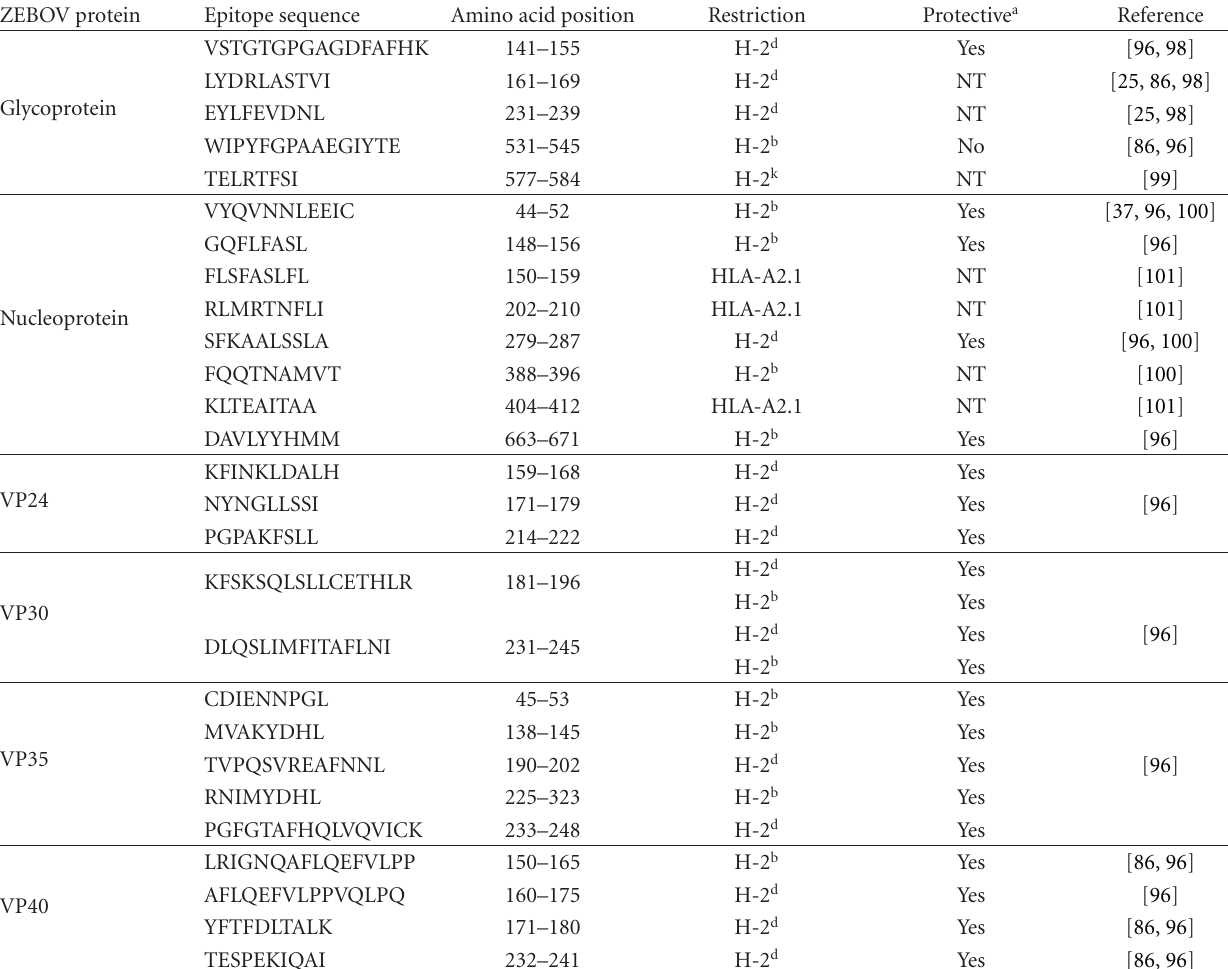
Table 1: ZEBOV protein sequences recognized by murine CD8 + T cells. The table is adapted and expanded from [97]. ZEBOV